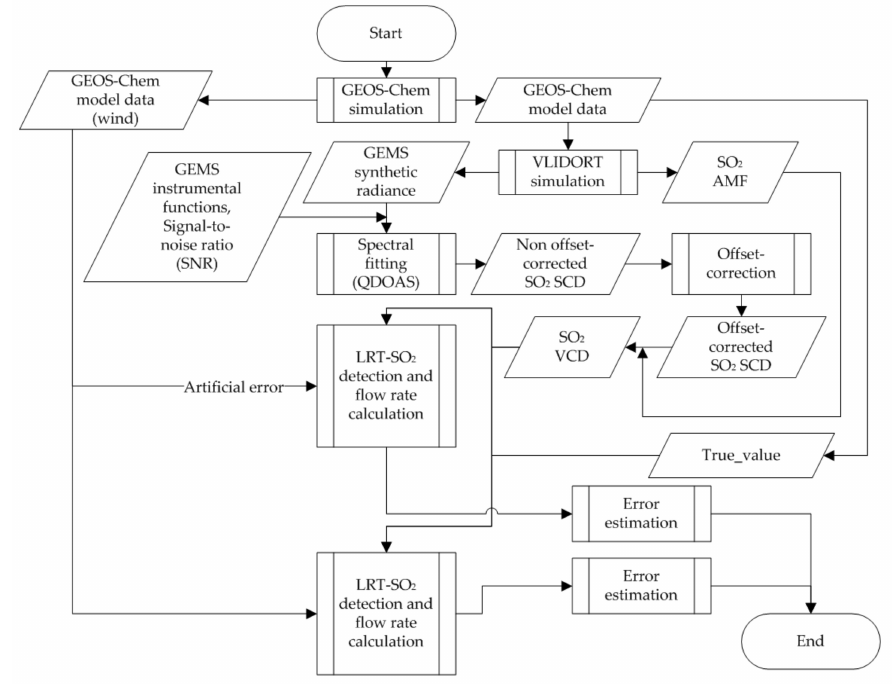
Figure 1. Flowchart of LRT-SO 2 flow rata and retrieval uncertainty